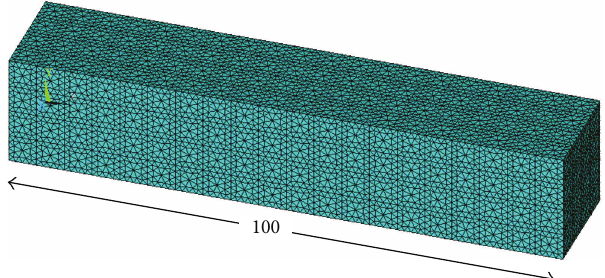
Figure 2: A typical meshed rectangular parallelepiped beam model.